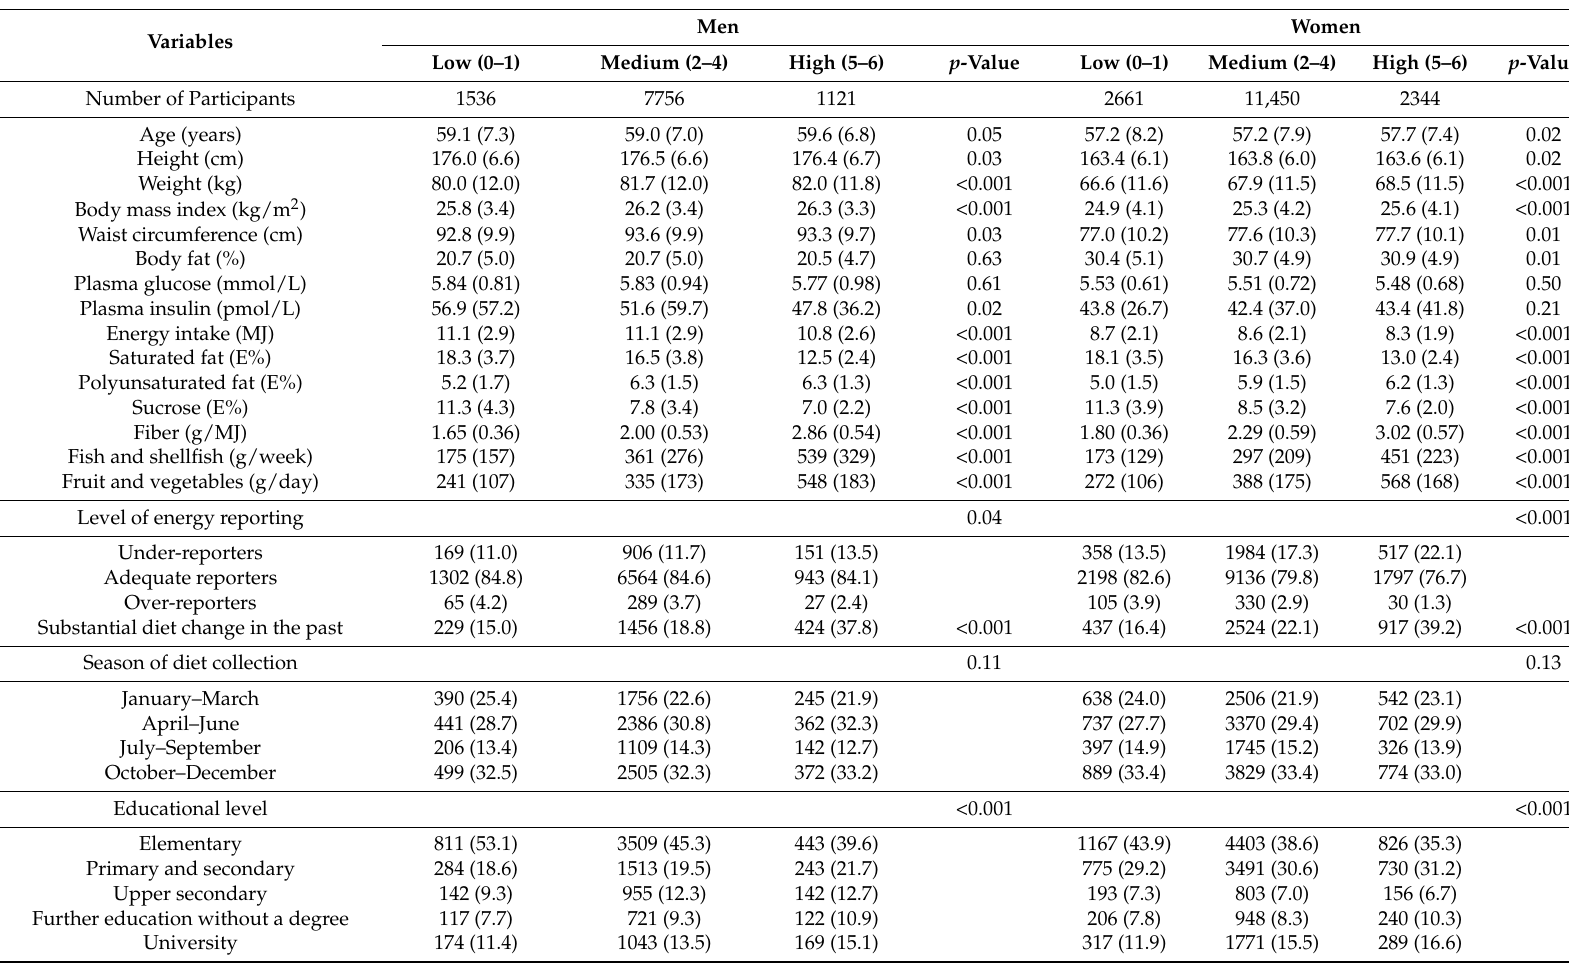
Table 1. Baseline characteristics of men ( n = 10,413) and women ( n = 16,455) in the Malmö Diet and Cancer cohort (1991–1996) by categories of diet quality index